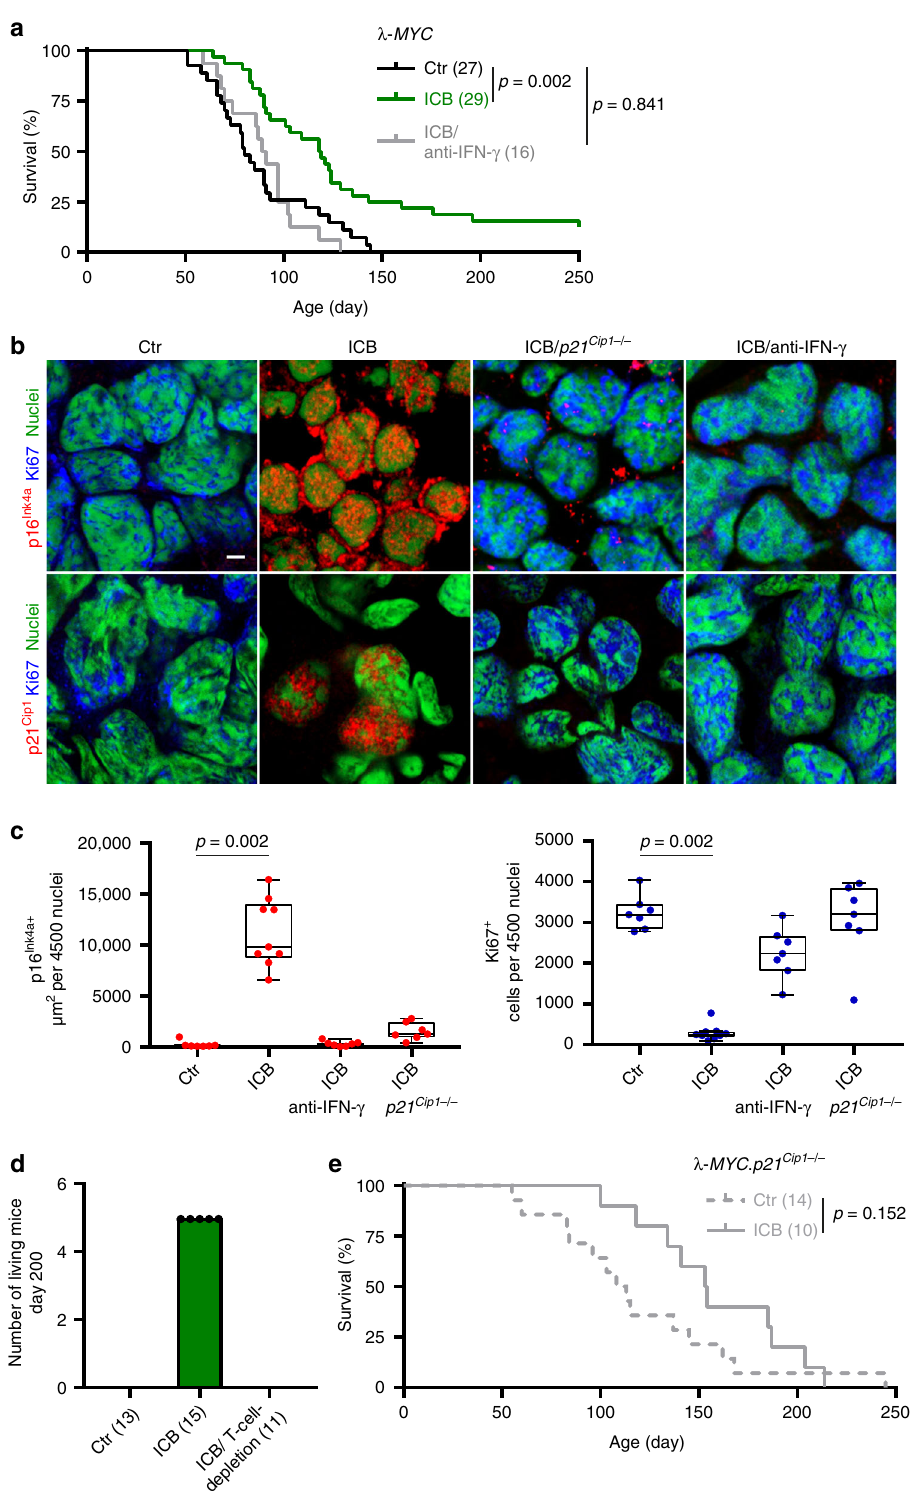
our case blue-green. “ The Magic Wand Tool ” was used to select and delete the white pixels (Supplementary Fig. 2b). The number of pixels correlates with the area of SA- β -gal stained tumour cells. The SA- β -gal stained tumour cells in Fig. 2d, Fig. 6d and Fig. 9c were calculated and given in percent (blue pixel of total pixels of the tumour